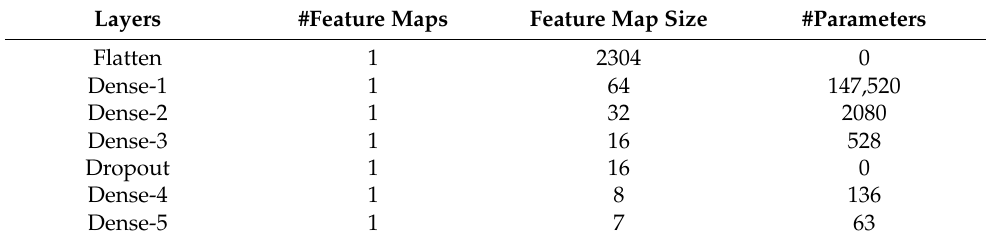
Table 4. Regression layer